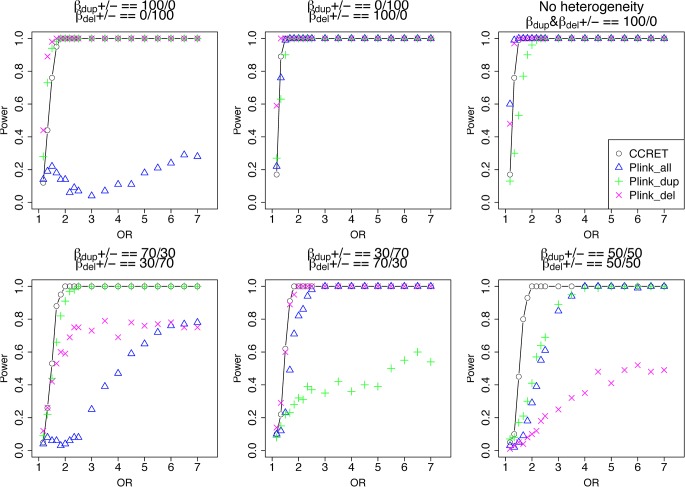
Power comparison between CCRET and PLINK 2-sided tests for simulation I-A: between-locus heterogeneity of the dosage simulation, under 6 heterogeneity models as in Fig 3.Black O line: CCRET; Blue Δ: PLINK 2-sided test analyzing deletions and duplications combined; Green +: PLINK 2-sided test analyzing only duplications; Magenta x: PLINK 2-sided test analyzing only deletions.